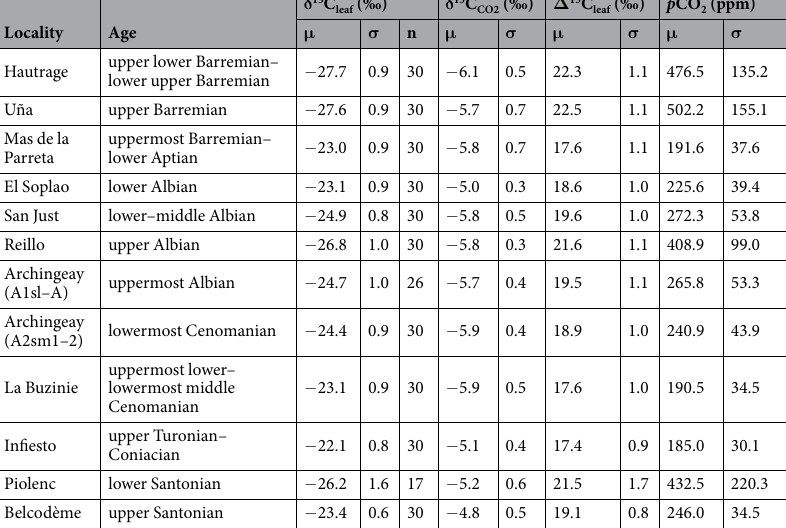
Table 1. δ 13 C leaf , δ 13 C CO2 , Δ 13 C leaf and p CO 2 values for the twelve studied Cretaceous stages. μ and σ correspond to mean and standard deviation, respectively.